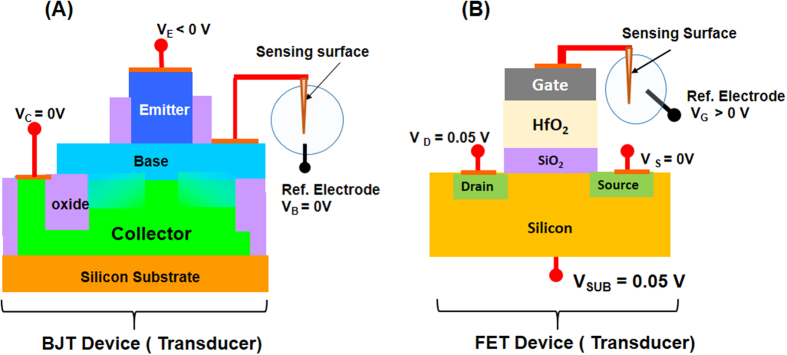
Electrochemical sensors with BJT and FET as transducers.Identical electrochemical sensors except for the transducer device type. (A) Schematic of an electrochemical sensor with a BJT device as the transducer; BJT base is connected to the silver chloride sensing surface that is immersed in the solution; a reference electrode is also immersed in the solution. Sensing signal (IC) is measured with the collector voltage (VC) and the base voltage VB held at 0 V, whilst the emitter voltage (VE) is either varied or held constant. (B) Schematic of an electrochemical sensor with a FET device as the transducer; FET gate is connected to the silver chloride sensing surface that is immersed in the solution; a reference electrode is also immersed in the solution. Sensing signal (ID) is measured with drain voltage VD = 50 mV, source (VS) and substrate (VSUB) voltages held at 0 V, whilst gate voltage VG is either varied or held constant.